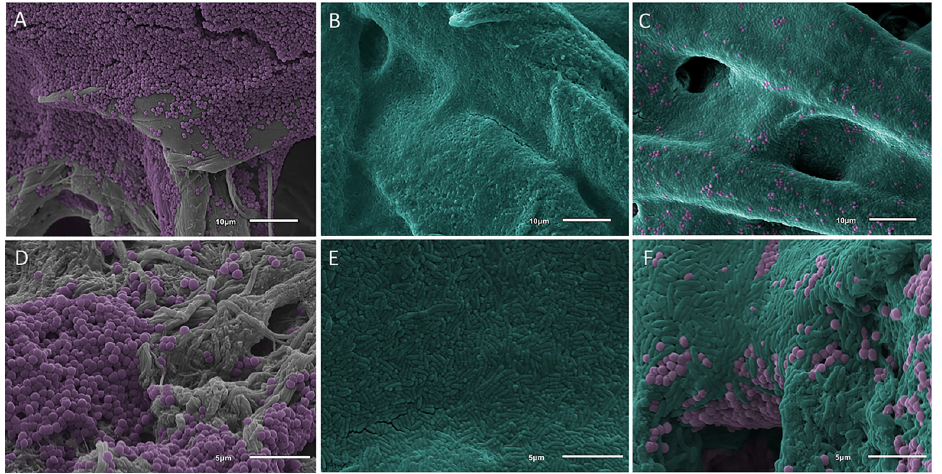
Fig 3. SEM images of MRSA (colored purple) and P . aeruginosa (colored teal) biofilms grown on cellulose and collagen. (A) MRSA biofilms on cellulose (gray substrate) after 48 h of growth. (B) P . aeruginosa biofilms on cellulose after 48 h of growth. The sheet-like growth of P . aeruginosa biofilms covered the substrate completely. (C) Polymicrobial biofilms of MRSA and P . aeruginosa on cellulose after 48 h of growth. P . aeruginosa grew in sheet-like structures with MRSA clusters observed throughout. (D) MRSA biofilm on collagen (gray substrate) after 48 h of growth. (E) P . aeruginosa biofilm on collagen after 48 h of growth. (F) Polymicrobial biofilms on collagen after 48 h of growth. Morphology was similar to that of cellulose with P . aeruginosa growing in sheet-like structures with MRSA clusters interspersed throughout.